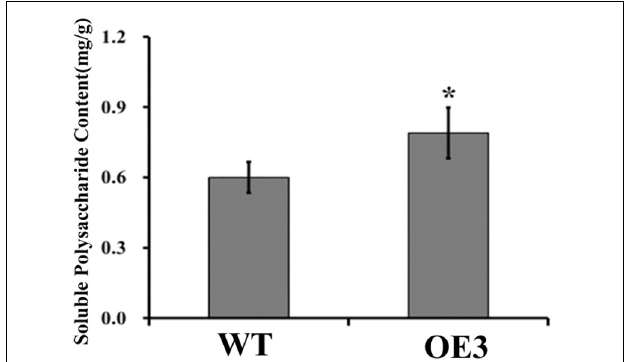
FIGURE 4 | Comparison of total soluble polysaccharide contents in wild-type (WT) and DoUGP overexpresssion (OE3) plants. Results are presented as mean ± standard error calculated from three biological replicates. Asterisk indicates statistically significant differences (Student’s t -test, p < 0.05).